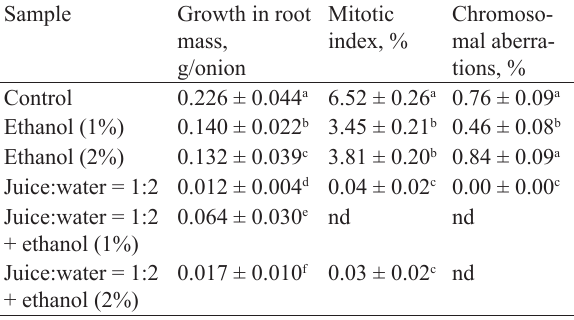
Table 4 Root mass growth, mitotic activity, and the frequency of chromosomal aberrations of onion root meristem cells after two days of treatment with apple juice and ethanol (n = 9)